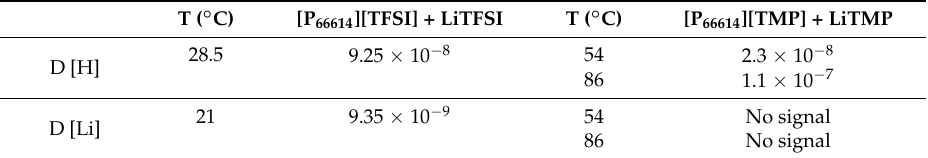
Table 3. Diffusion coefficient (in cm 2 · s − 1 ) of phosphonium